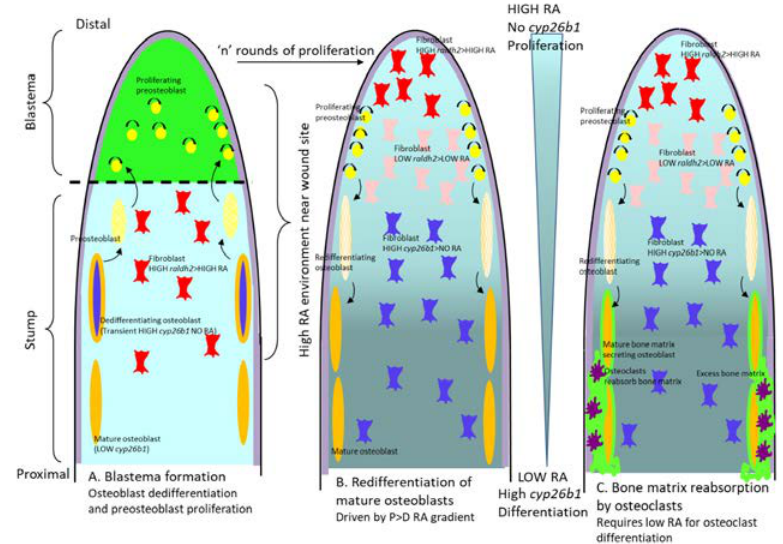
Figure 7. Cell autonomous and cell-non autonomous regulation of RA availability by CYP26 enzymes during zebrafish fin regeneration. ( A ). Blastema formation. A high RA environment produced by